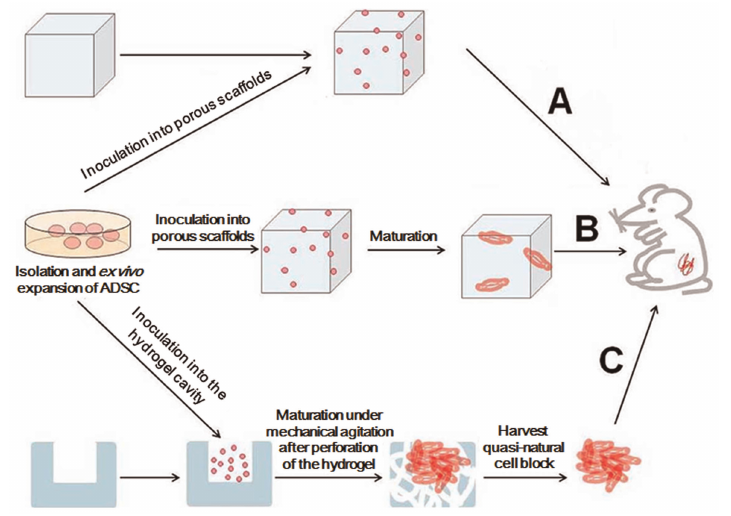
Figure 1. Schematic diagram of strategies to transplant adherent somatic cells. A, Transplanta- tion of adherent somatic cells based on a mixture approach. B, Transplantation of adherent somatic cells by 3D culture. C, Transplantation of adherent somatic cells through manipulation of the quasi- natural cell